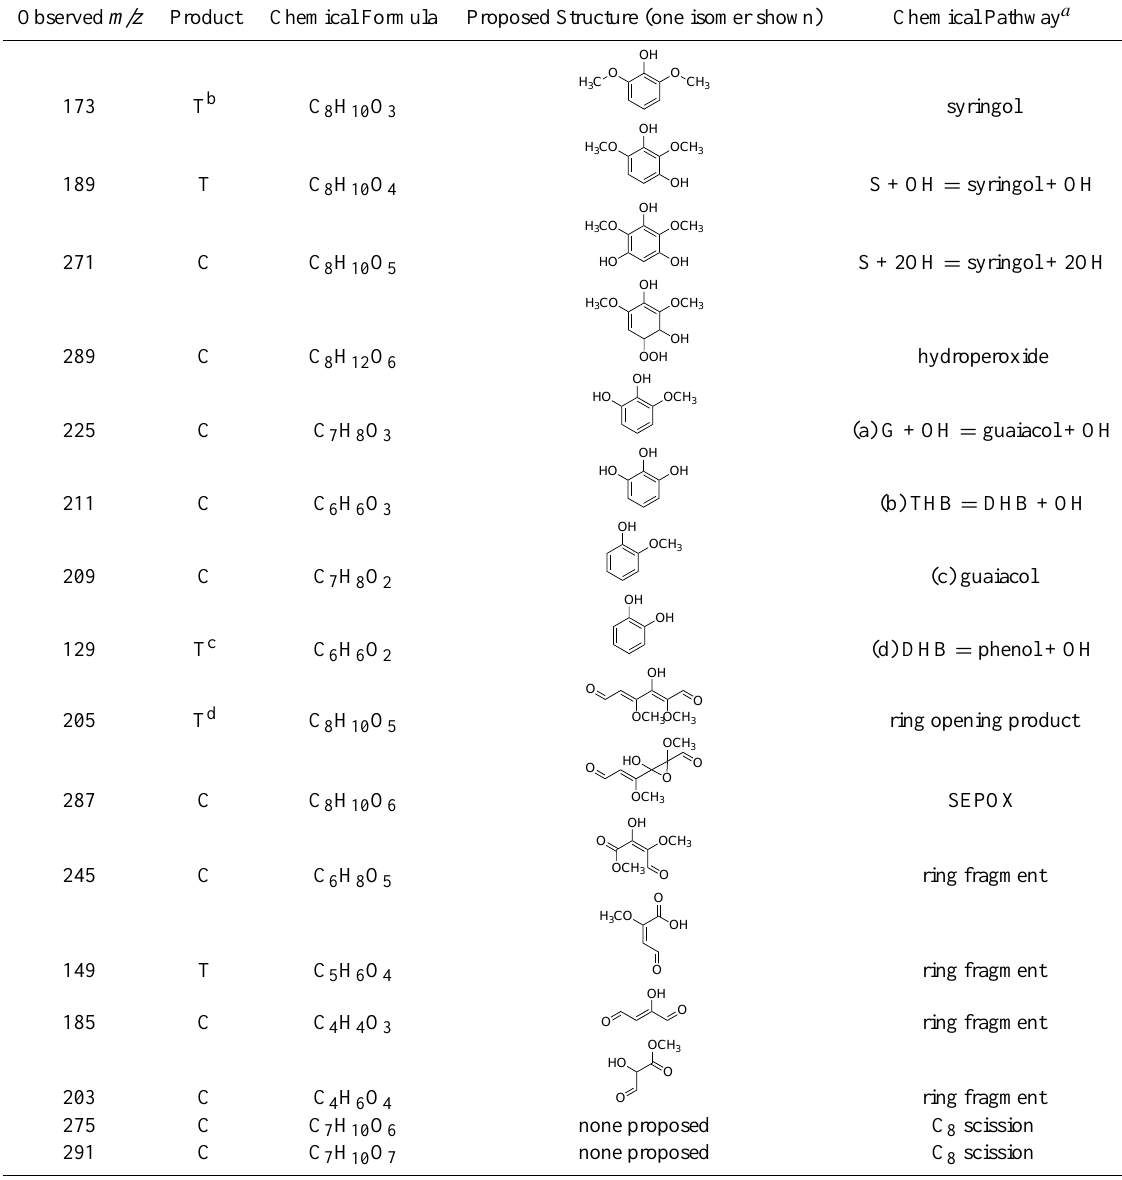
Table 6. Proposed structures for CIMS ions in the syringol low-NO x system. C and T indicate the cluster and transfer product, respectively. Observed